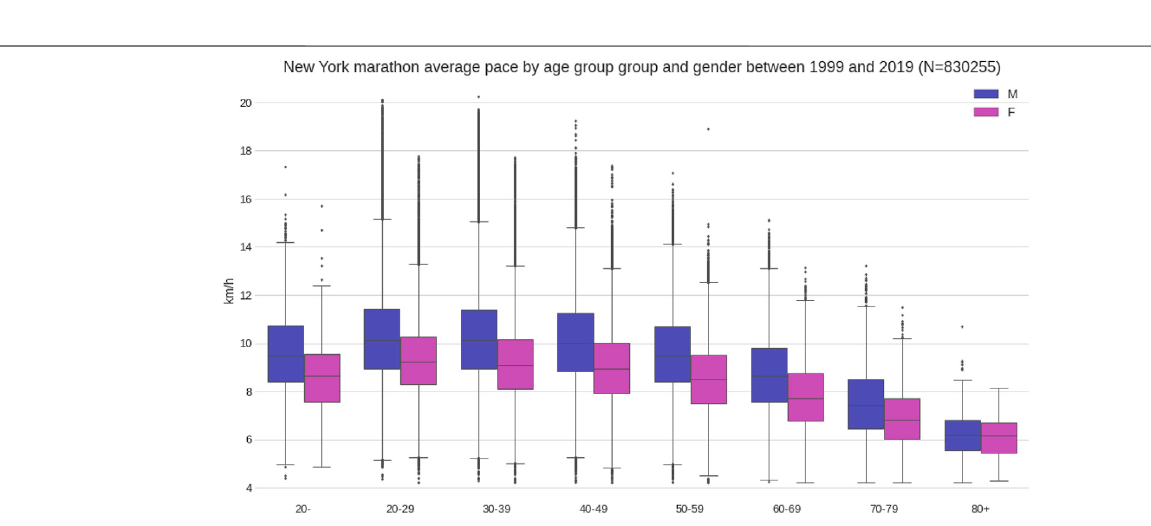
FIGURE 2 | Trend of female and male runners and the male-to-female ration.